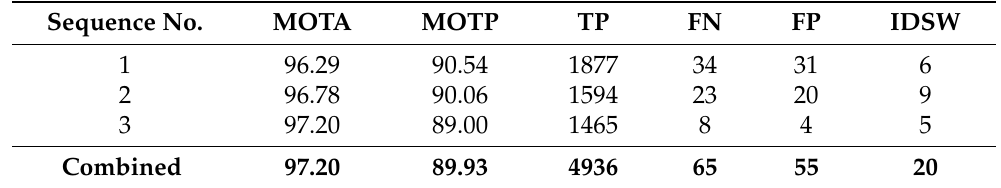
Table 5. Scenario 2—category 2 Quantitative results of the tracker’s performance to track objects of category 2 (tugboat) in scenario 1. Scenario 1 consists of three sequences involving only moving objects, and no occlusion or dynamic movement of the camera is